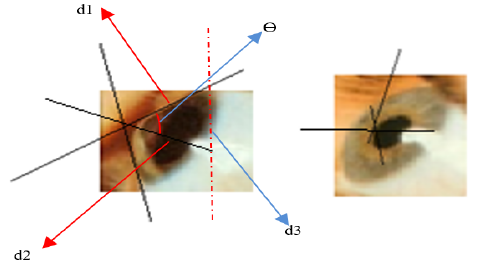
Figure 9. Corneal curvature slopes and angles computation.